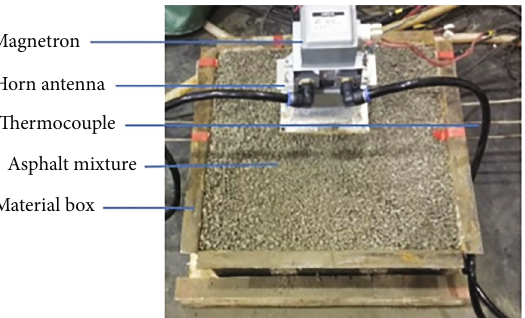
Figure 6: A microwave heating unit.